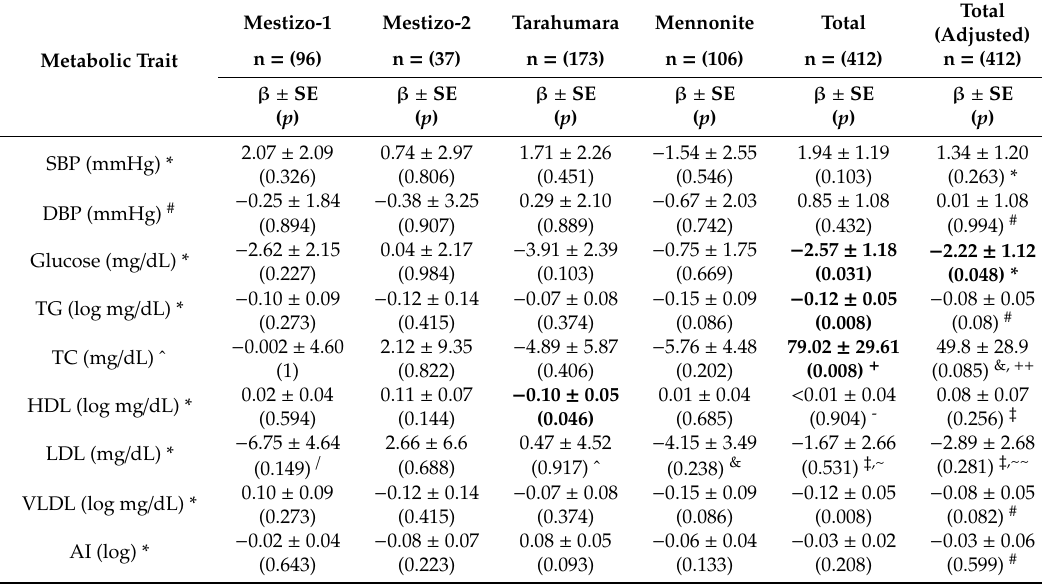
Table 7. Association between + 294T / C PPAR- δ polymorphism and metabolic traits in studied populations.